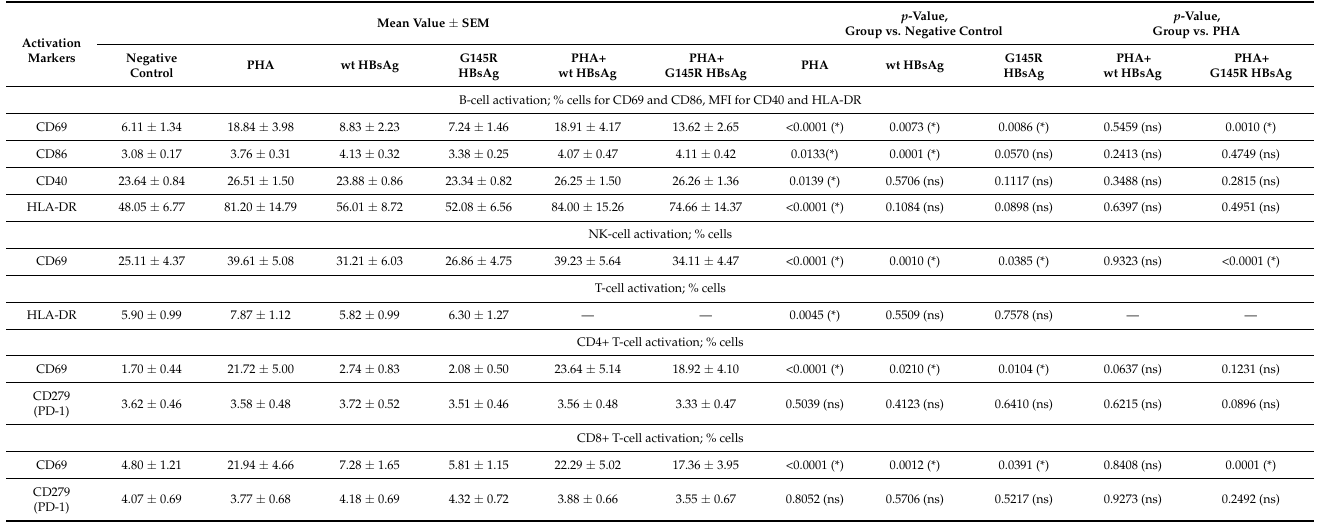
Table 2. Effects of stimulation of PBMC from healthy donors with wild-type rHBsAg (ayw2) and the rHBsAg G145R mutant (ayw2) 1